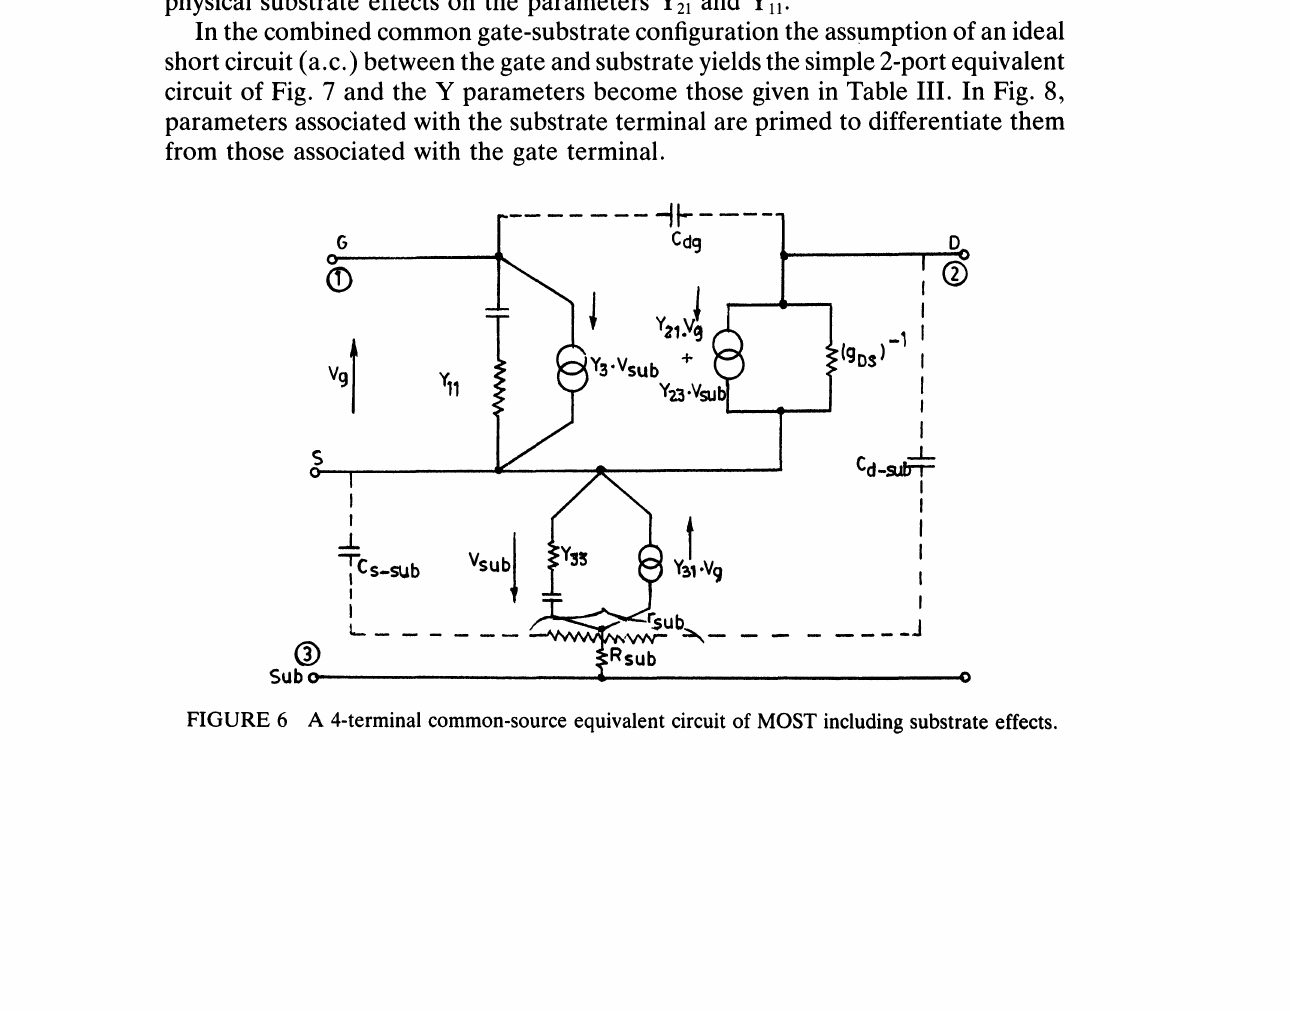
FIGURE 6 A 4-terminal common-source equivalent circuit of MOST including substrate